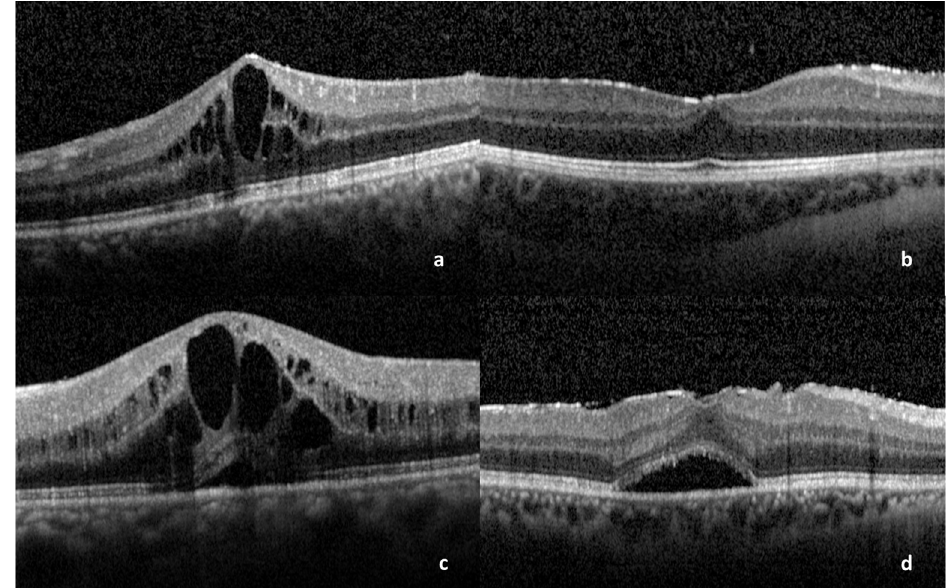
Figure 1. OCT scans showing: ( a ) Cystoid ME. ( b ) Diffuse ME. ( c ) SRD associated with cystoid ME. ( d ) SRD associated with diffuse ME. ME: macular edema, SRD: serous retinal detachment.